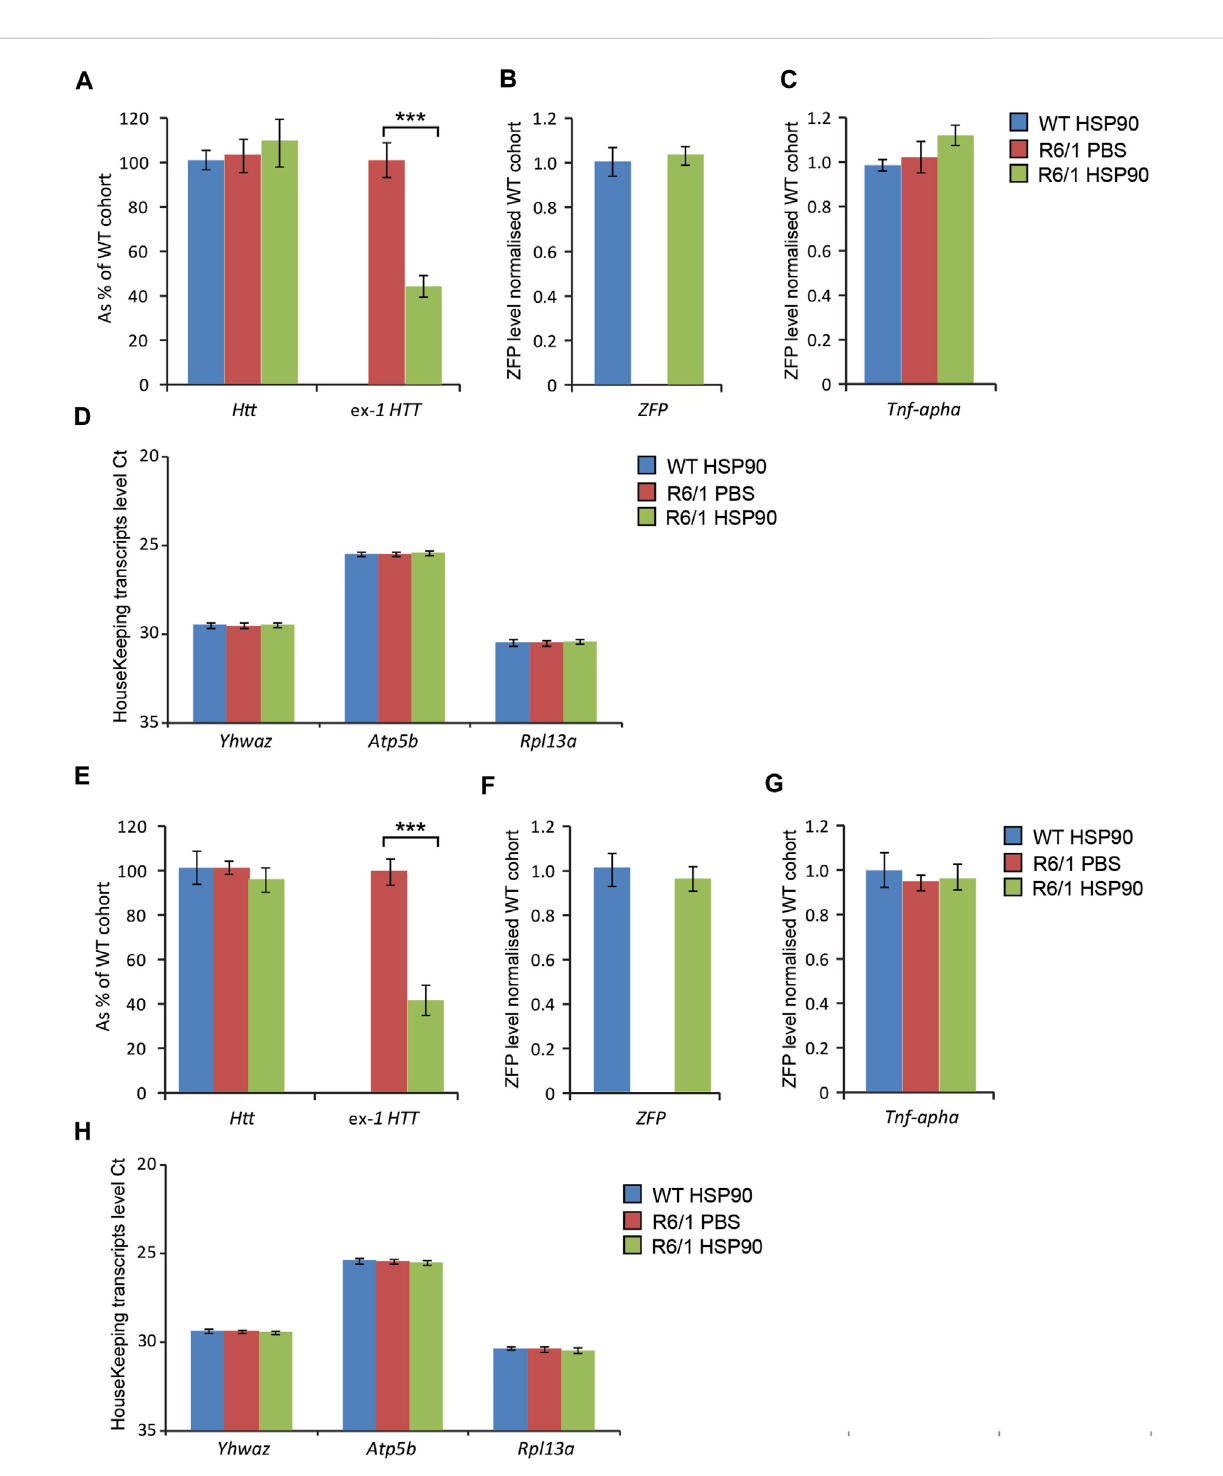
FIGURE 5 Effects of intramuscular injection of AAV expressing mZF-KRAB under the HSP90 promoter. Tibialis anterior (TA) muscles of the 3 month old wild- type and R6/1 mice were injected with either PBS or with AAV2/9, carrying mZF-KRAB under the HSP90 promoter, and the tissue was harvested either 3weeks (A – D) or6weeks (E – H) postsingle injection.TheunchangedexpressionofWTHTTtranscriptsaswelltherepressionofmutantHuntingtinmut- Exon1 in TA was apparent either 3 weeks (A) or 6 weeks (E) post single intramuscular injection. There was an apparent expression of the zinc fi nger mZF-KRAB transcript in the TA muscles of WT and R6/1 mice at both time-points at 3 weeks (B) and 6 weeks (F) . Tnf-alpha (Tumor necrosis factor alpha transcript levels remained unchanged in the TA muscle expressing mZF-KRAB transcripts either 3 weeks (C) or 6 weeks (G) post single intramuscular injection. All transcript levels were normalized to three housekeeping genes: Raw crossing threshold (Ct) data for a panel of housekeeping genes are presented for thefollowing genetranscripts: Ywhaz (Phospholipase A2,22631), Atp5b (ATPsynthase subunit, 11947)and Rpl13a (Ribosomal proteinL13a, 22121). Error bars are ±SEM ( n = 12). ** p < 0.01, *** p <